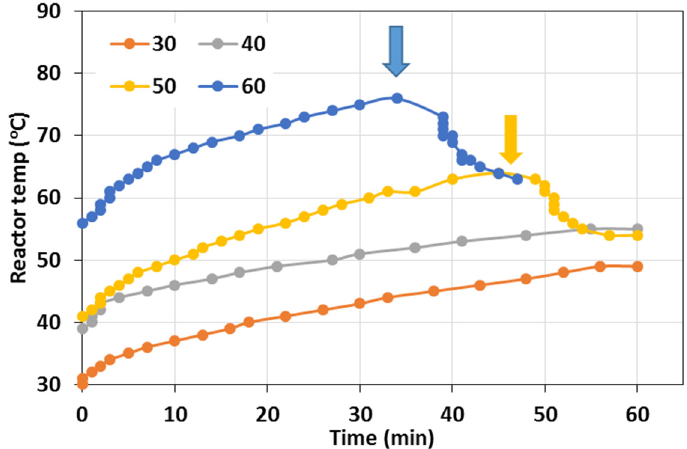
Figure 12. Change in the reactor temperature during the hydrogenation of cyclohexene over Pt-ZSM-5. Arrows are pointing to the 100% conversion of cyclohexene.